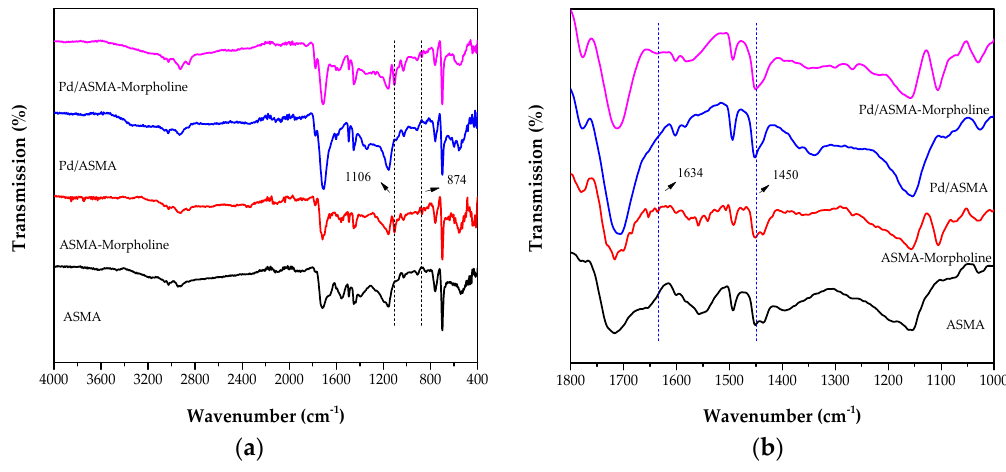
Figure 5. Infrared spectra of ASMA samples of pure sample (black), modified with morpholine (red), loaded with Pd (blue), and loaded with Pd after being modified with morpholine (magenta) recorded at room temperature, showing the range of ( a ) 4000–400 cm − 1 and ( b ) 1800–1000 cm − 1 .